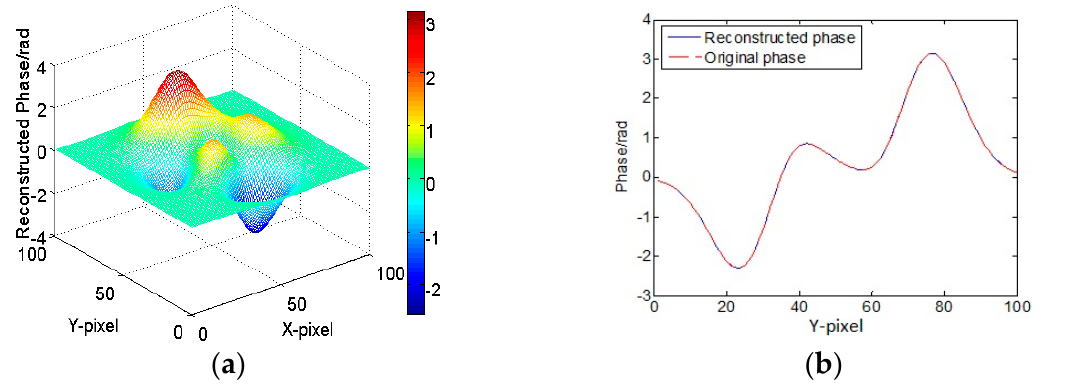
Figure 2. Reconstructed phase using Liu and Poon’s method. ( a ) 3D reconstructed phase distribution; ( b ) Phase line trace along Y at X-pixel = 50 on Figure 2a and the same section of the original phase.